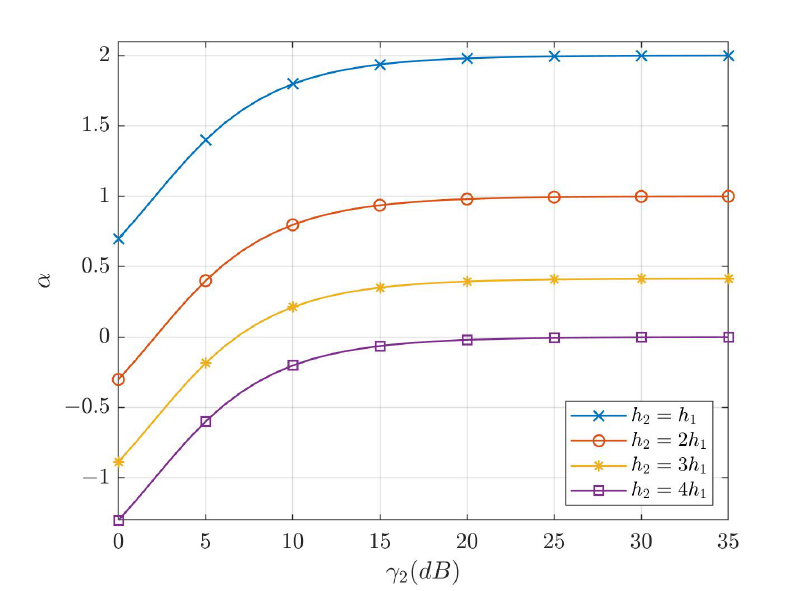
Figure 8. Optimal values of the optimization parameter α that minimize SER 2